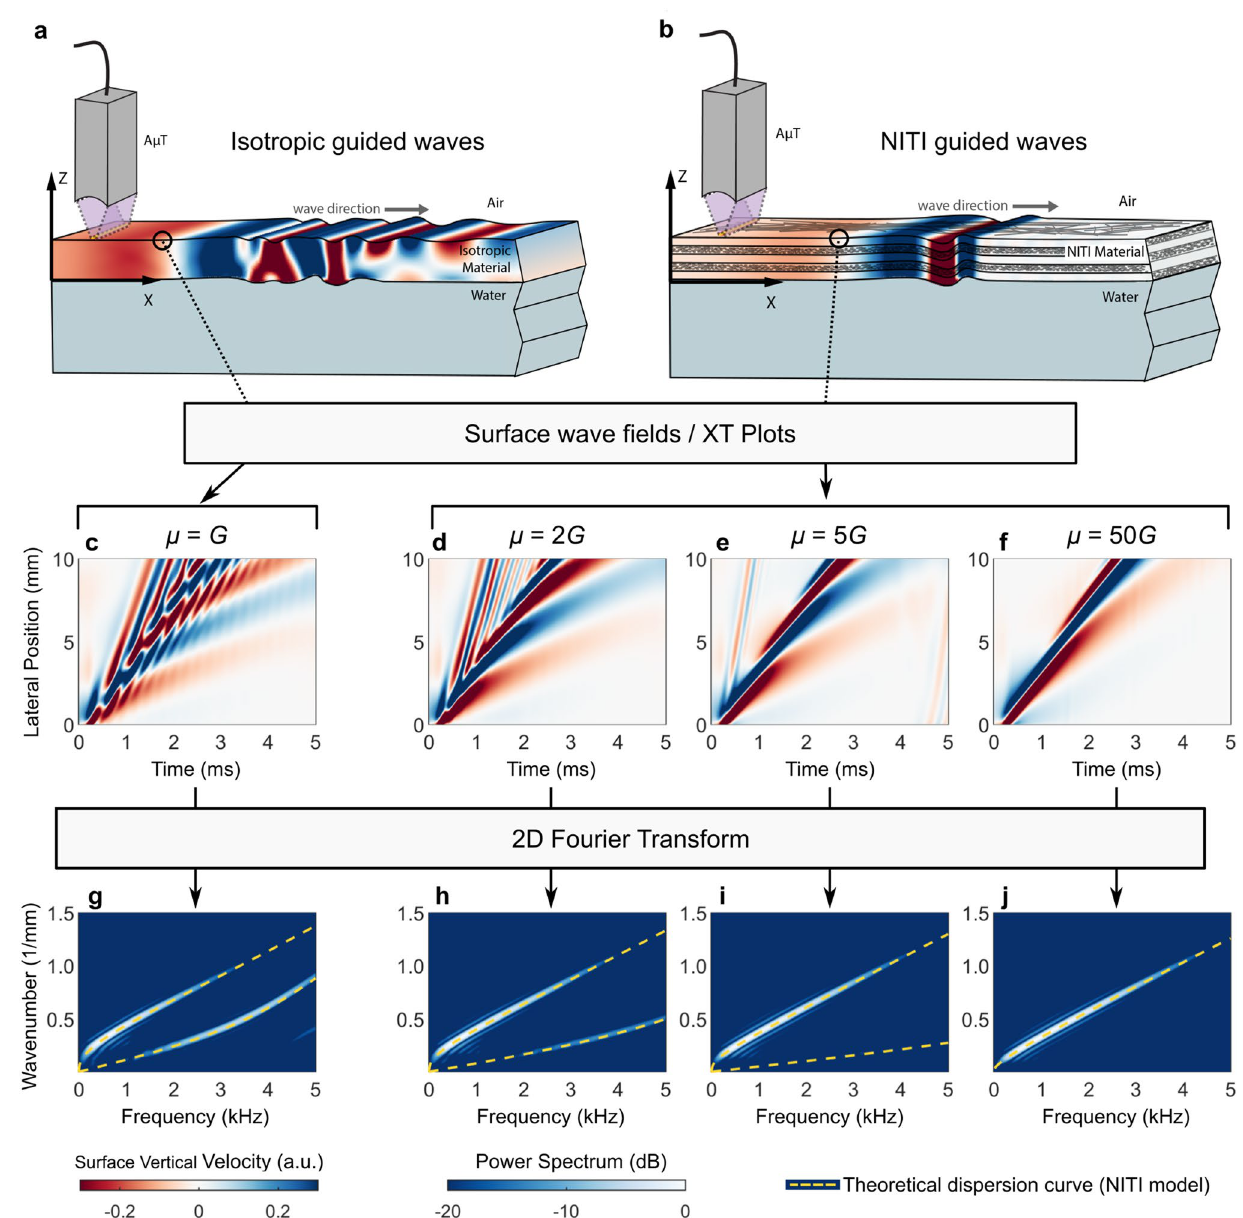
Figure 3. Numerical solutions for guided wave propagation in a bounded NITI medium. Guided mode wave fields simulated in OnScale for ( a ) isotropic and ( b ) NITI layers. Guided wave excitation was simulated with the AμT line source, closely mimicking experimental conditions (see Supplementary Note 5). Extracting guided mode wave fields from the material surface yields XT plots ( c – f ) and corresponding 2D Fourier spectra ( g – j , presented on a log scale over a 20 dB display dynamic range) for various levels of anisotropy. A 0.55 mm thick NITI layer ( G = 20 kPa; μ = 20 kPa, 40 kPa, 100 kPa, 1 MPa) is